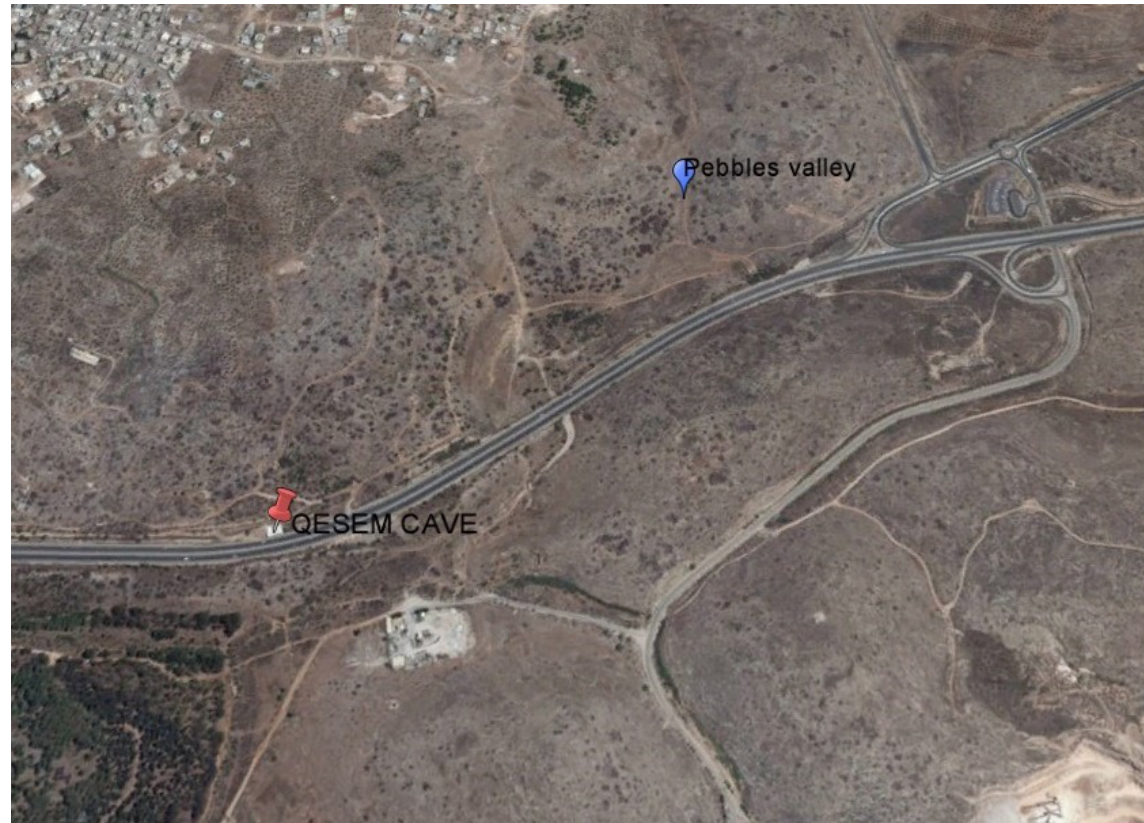
Figure 3. Qesem cave and the possible origin of the pebbles (stream